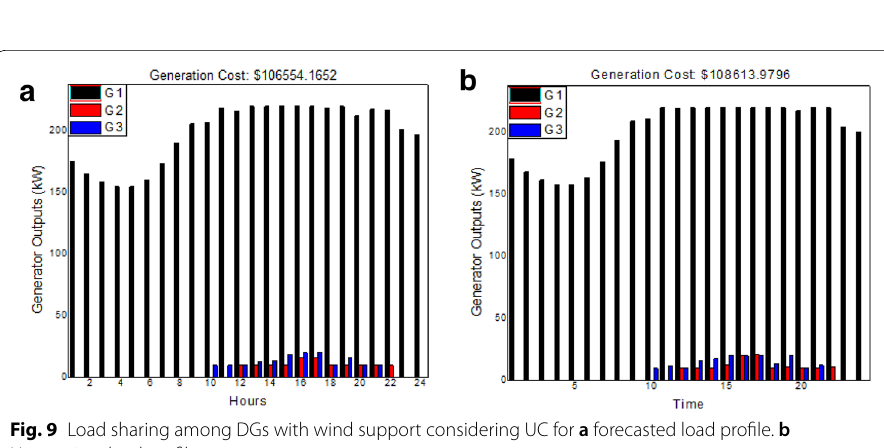
Fig. 9 Load sharing among DGs with wind support considering UC for a forecasted load profile.